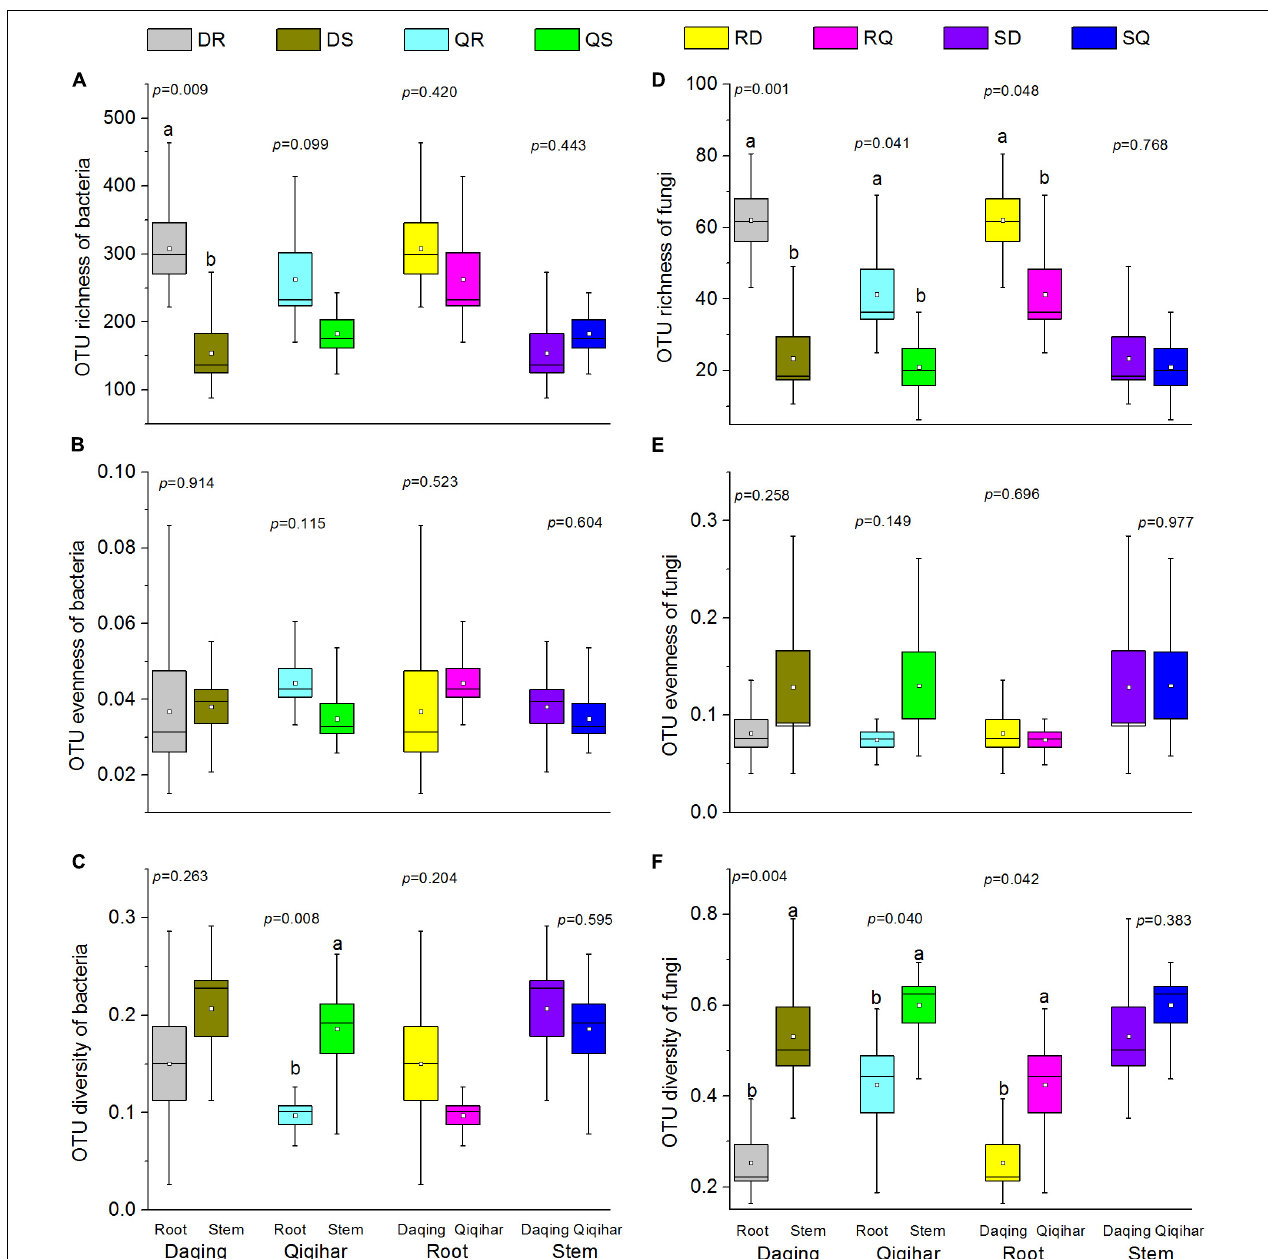
FIGURE 2 | Alpha diversity estimates of bacterial and fungal communities in different environmental conditions and different tissues. (A) Operational taxonomic unit (OTU) richness of bacteria. (B) OTU evenness of bacteria. (C) OTU diversity of bacteria. (D) OTU richness of fungi. (E) OTU evenness of fungi. (F) OTU diversity of fungi. The richness, evenness, and diversity of bacterial and fungal communities are displayed with the bootstrap, simpsoneven, and Shannon indices, respectively. Box plots display the first (25%) and third (75%) quartiles, the median, mean, and the maximum and minimum observed values within each data set. Alpha diversity estimates represent three biological replicates for each set. Data were analyzed using Student’s t- test. The overall plant compartment effects ( p- value) are displayed at the top of each graph. Significant differences ( p < 0.05) across plant compartments are indicated using lowercase letters.